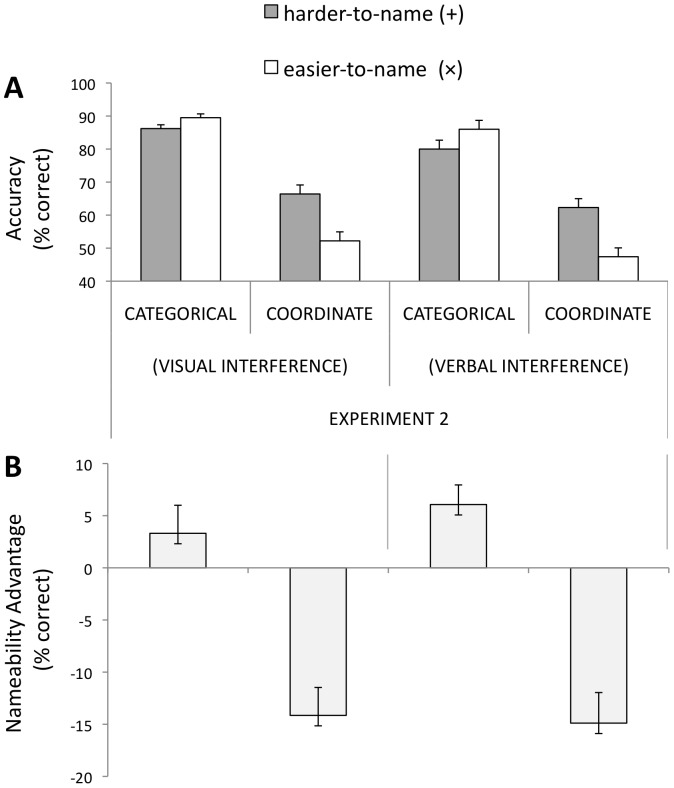
Accuracy results for Experiment 2 (visual vs. verbal interference).(A) Overall % accuracy for all different trials. (B) Nameability advantage (easier-to-name trials minus harder-to-name trials). A positive difference score indicates an advantage on easier-to-name trials; a negative score indicates a disadvantage on easier-to-name trials. Error bars represent 1SE of the mean difference between easier-to-name and harder-to-name trials.